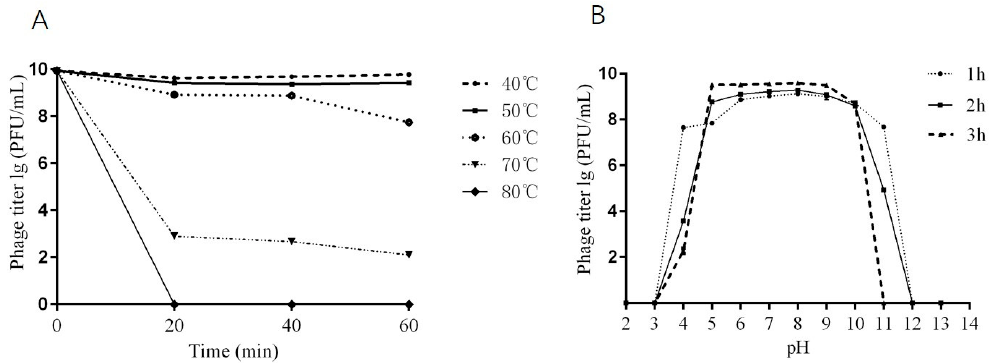
Figure 3. Thermal and pH stability of phage DCp1. ( A ) The titers of phage DCp1 at different tem- peratures (40 °C, 50 °C, 60 °C, 70 °C, and 80 °C) and different time points (20, 40, and 60 min). ( B ) The titers of phage DCp1 at different pHs (3~13) and different time points (1, 2, and 3 h).